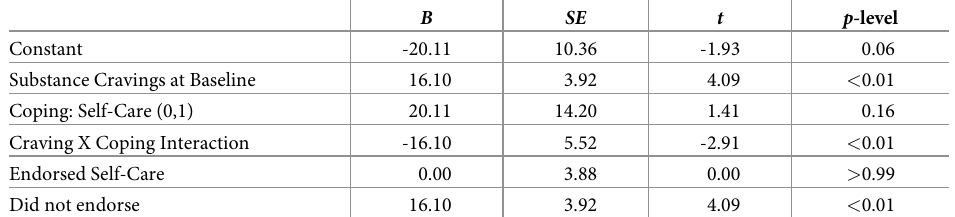
Table 7. Interaction between baseline substance cravings and self-care to predict days using substances at follow-